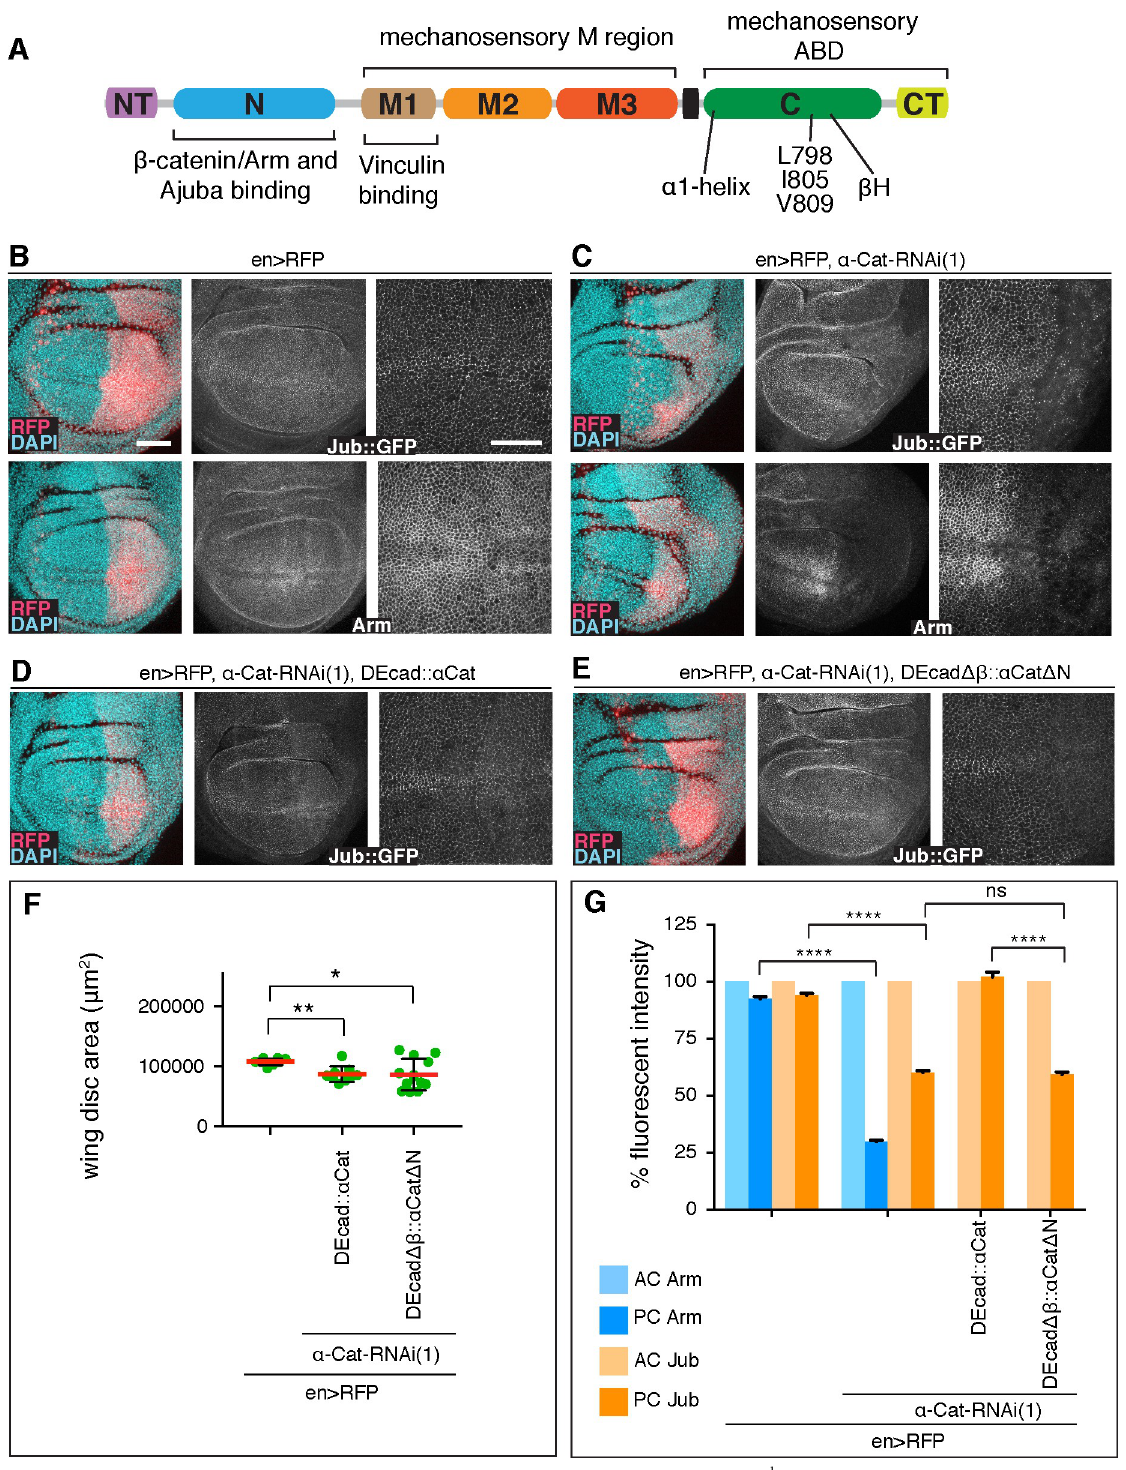
Fig 4. The α -Cat N domain recruits Jub to AJs. (A) α -Cat protein structure. (B) Control late 3 rd larval instar discs expressing en-Gal4 , UAS-RFP and Jub::GFP, controlled by its endogenous promoter (upper panels), were stained for Arm (lower panels). Nuclei are labeled with DAPI. Close-up images to the right show wing pouch area on both sides of the anterior-posterior compartment boundary. Scale bars, 50 μ m and 25 μ m. (C) Same markers as in (A) with UAS- α -CatRNAi(1) expression in PC. (D) Late 3 rd larval instar discs expressing Jub::GFP, en- Gal4 , UAS-RFP , UAS- α -Cat-RNAi(1) , and UAS-DEcad :: α Cat . (E) Late 3 rd larval instar discs expressing Jub::GFP, e n-Gal4 , UAS-RFP , UAS-